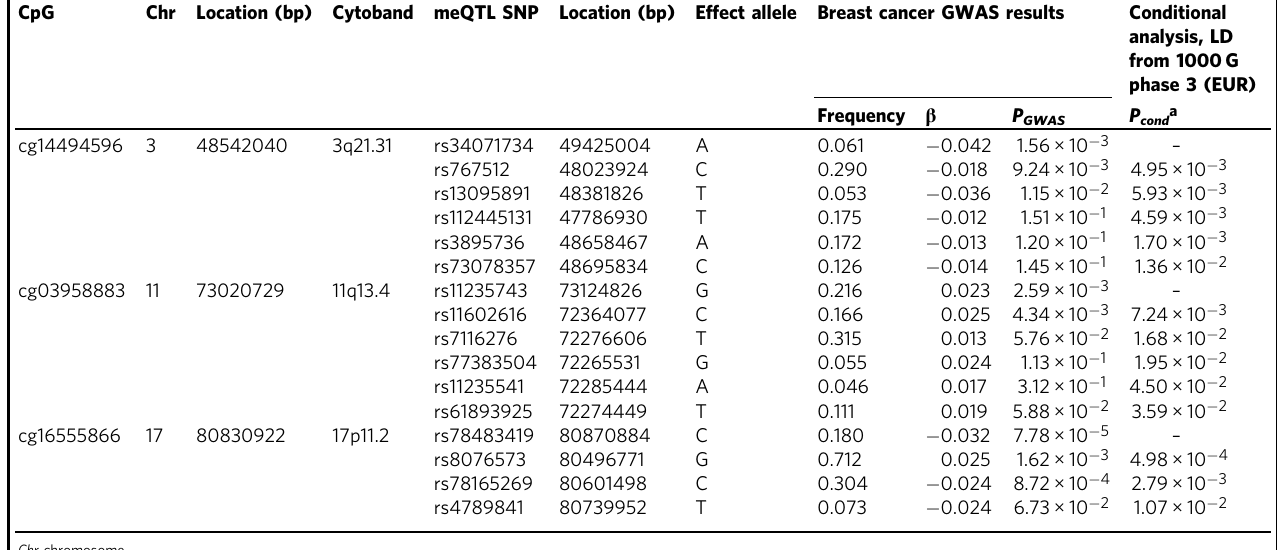
Table 3 Signi fi cant secondary associations identi fi ed around selected breast cancer CpGs through conditional analysis of predictor meQTL